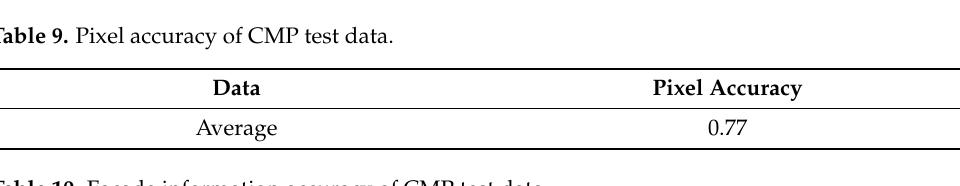
Table 10. Façade information accuracy of CMP test data.